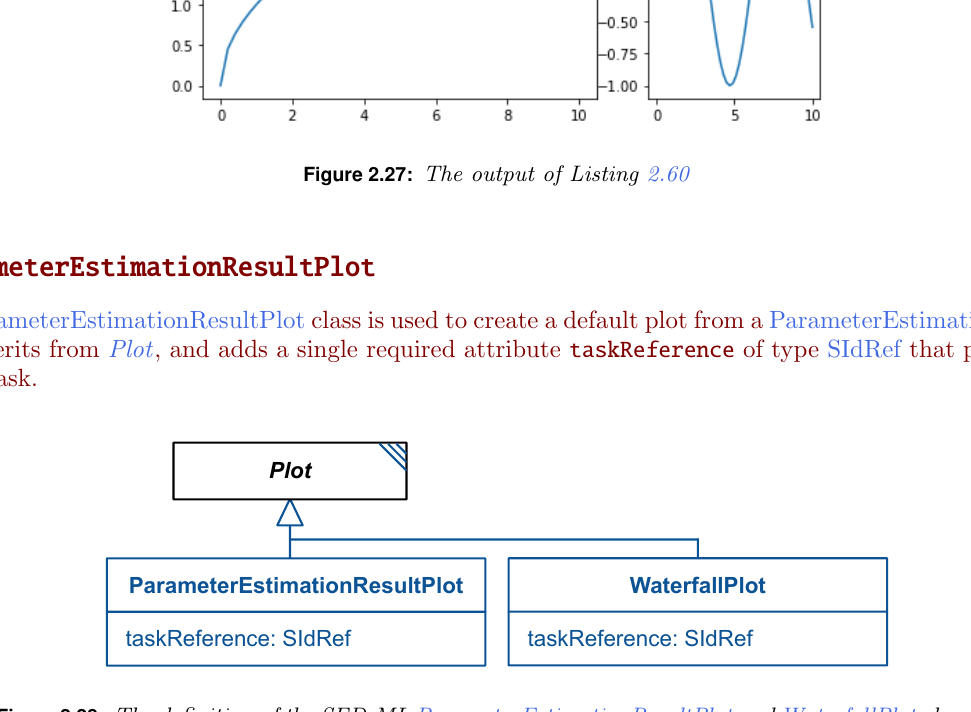
Figure 2.28: The definition of the SED-ML ParameterEstimationResultPlot and WaterfallPlot